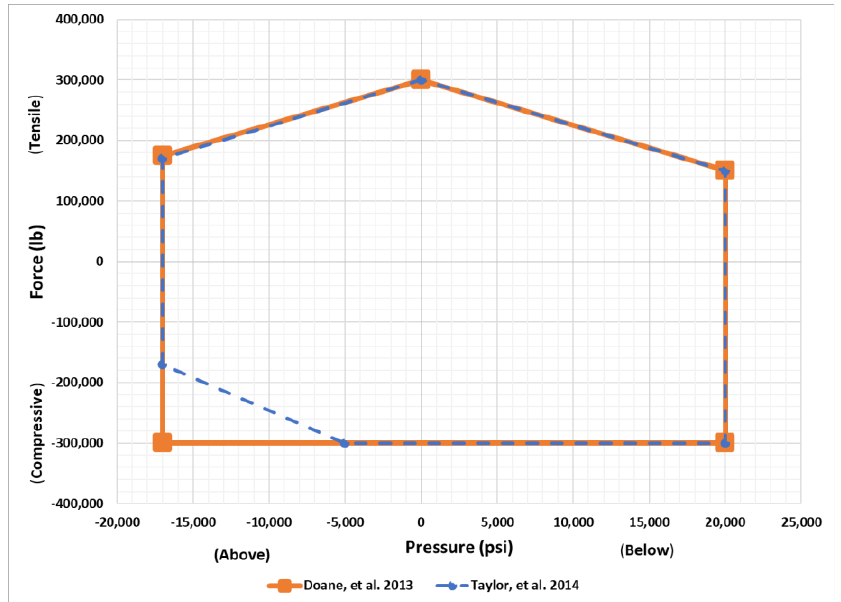
Figure 12. Plotted performance curve of the permanent packers (reconstructed after dataset from [60,76]).